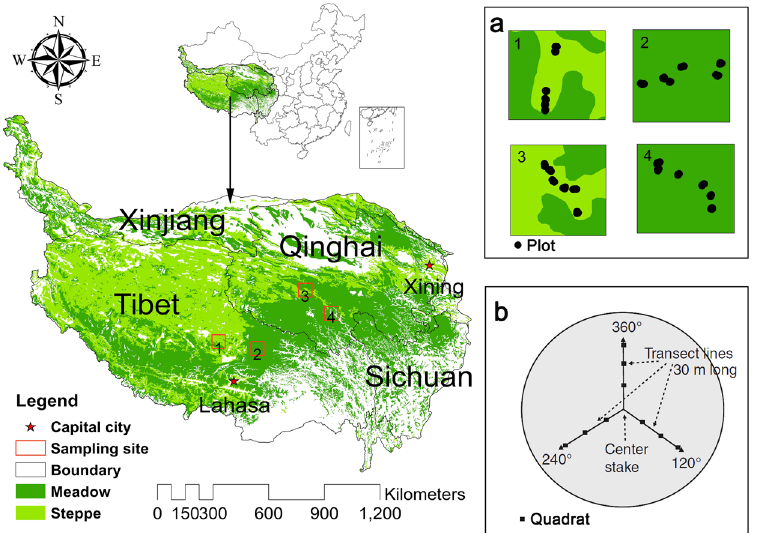
Figure 8. Location of the study area and distributions of the sampling sites. The words represent provinces in the Qinghai-Tibet Plateau. 1, 2, 3, and 4 represent sites of Baingoin County, Nagchu County, Quma River Township, and Qumarleb county, respectively. ( a ) Distributions of total 64 plots in four sites. ( b ) Distribution of 9 quadrats in each plot. The map was edited and generated with ArcGIS 10.2.2,